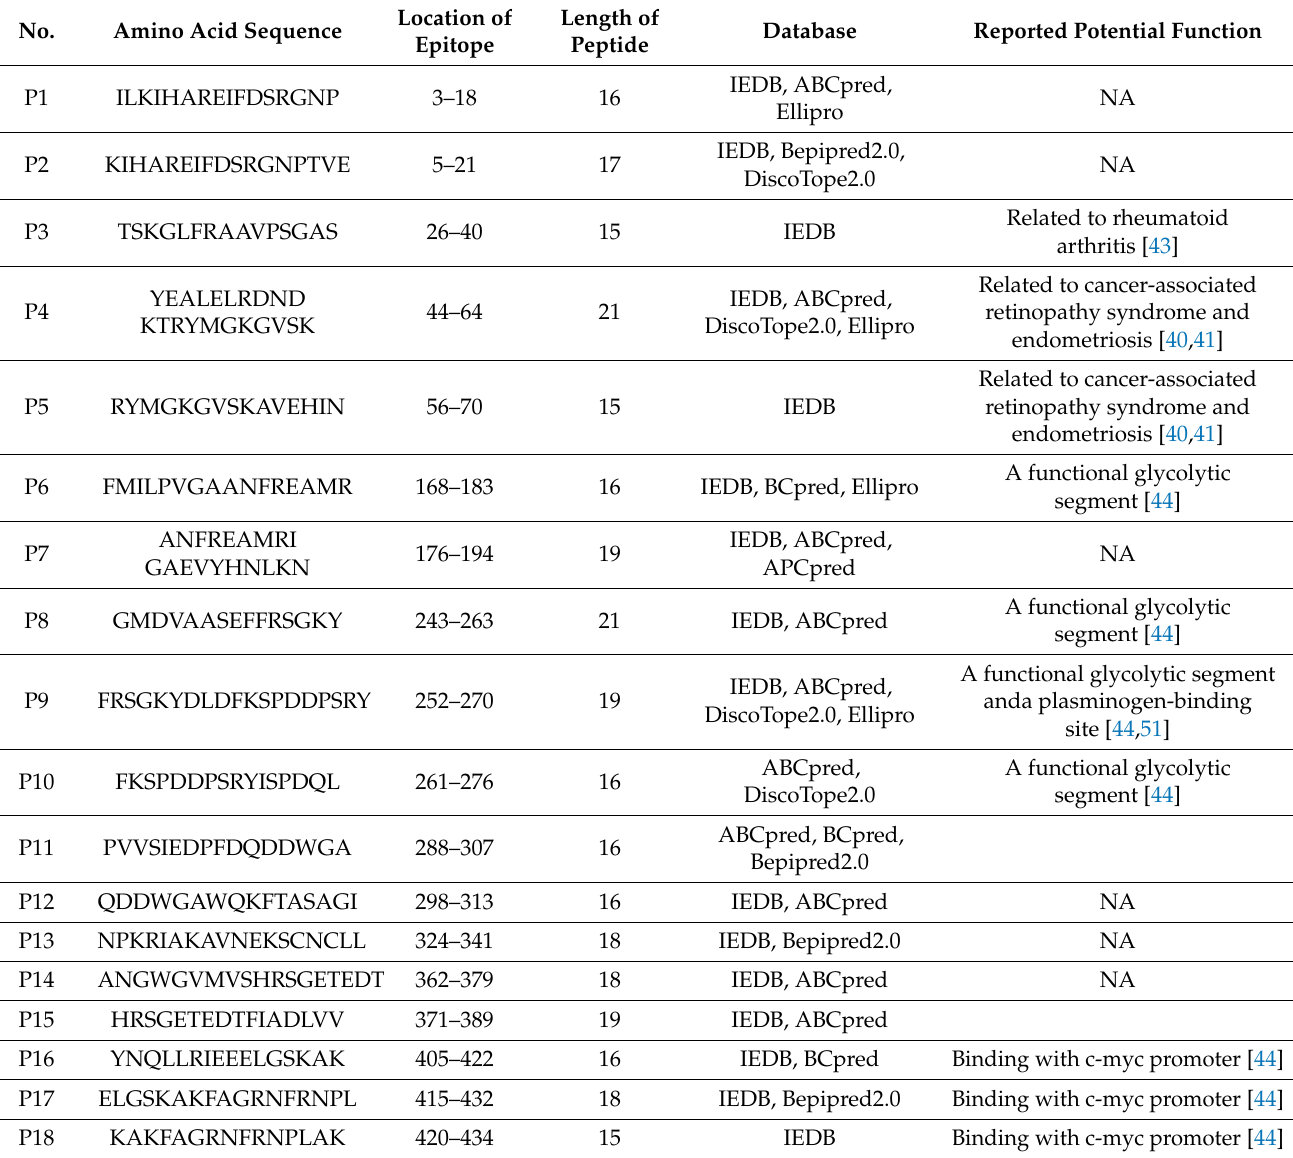
Table 5. The 18 selected antigenic epitopes of human ENO1 protein predicted by